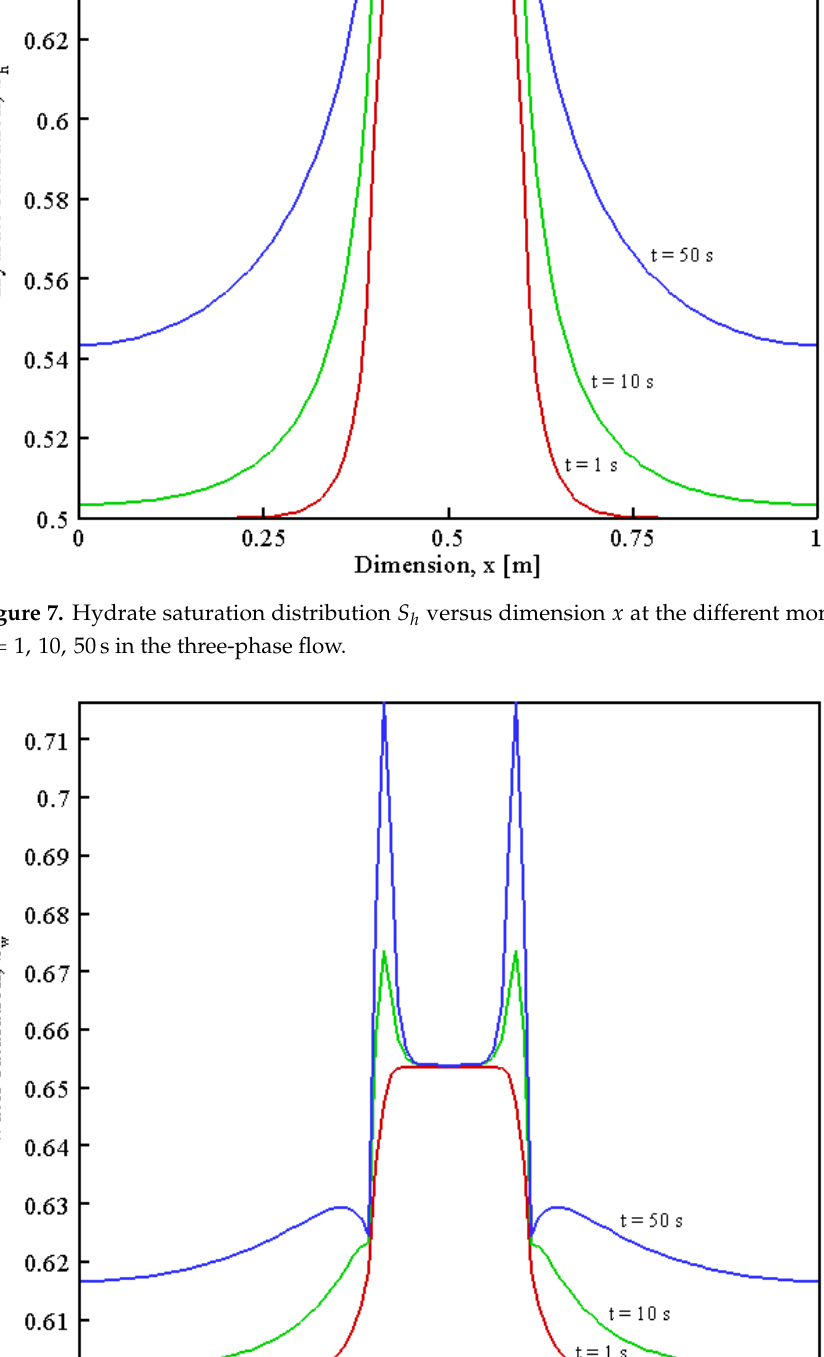
x at the different moments of